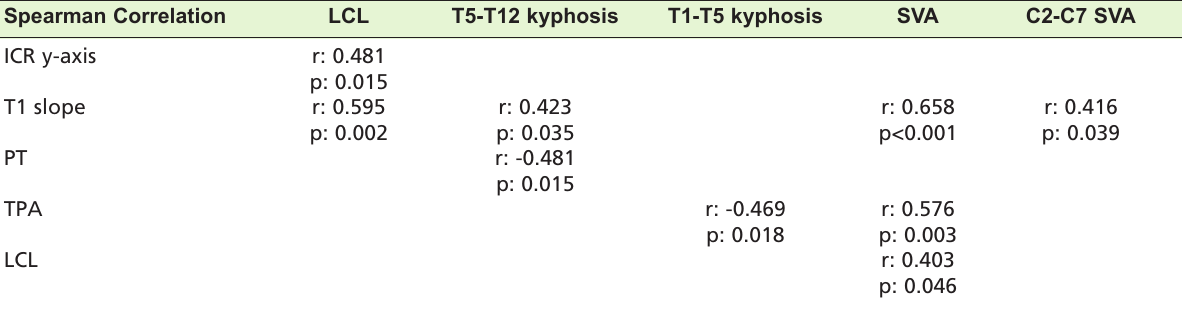
Table II: Spearman correlation results of the significant variables Spearman Correlation